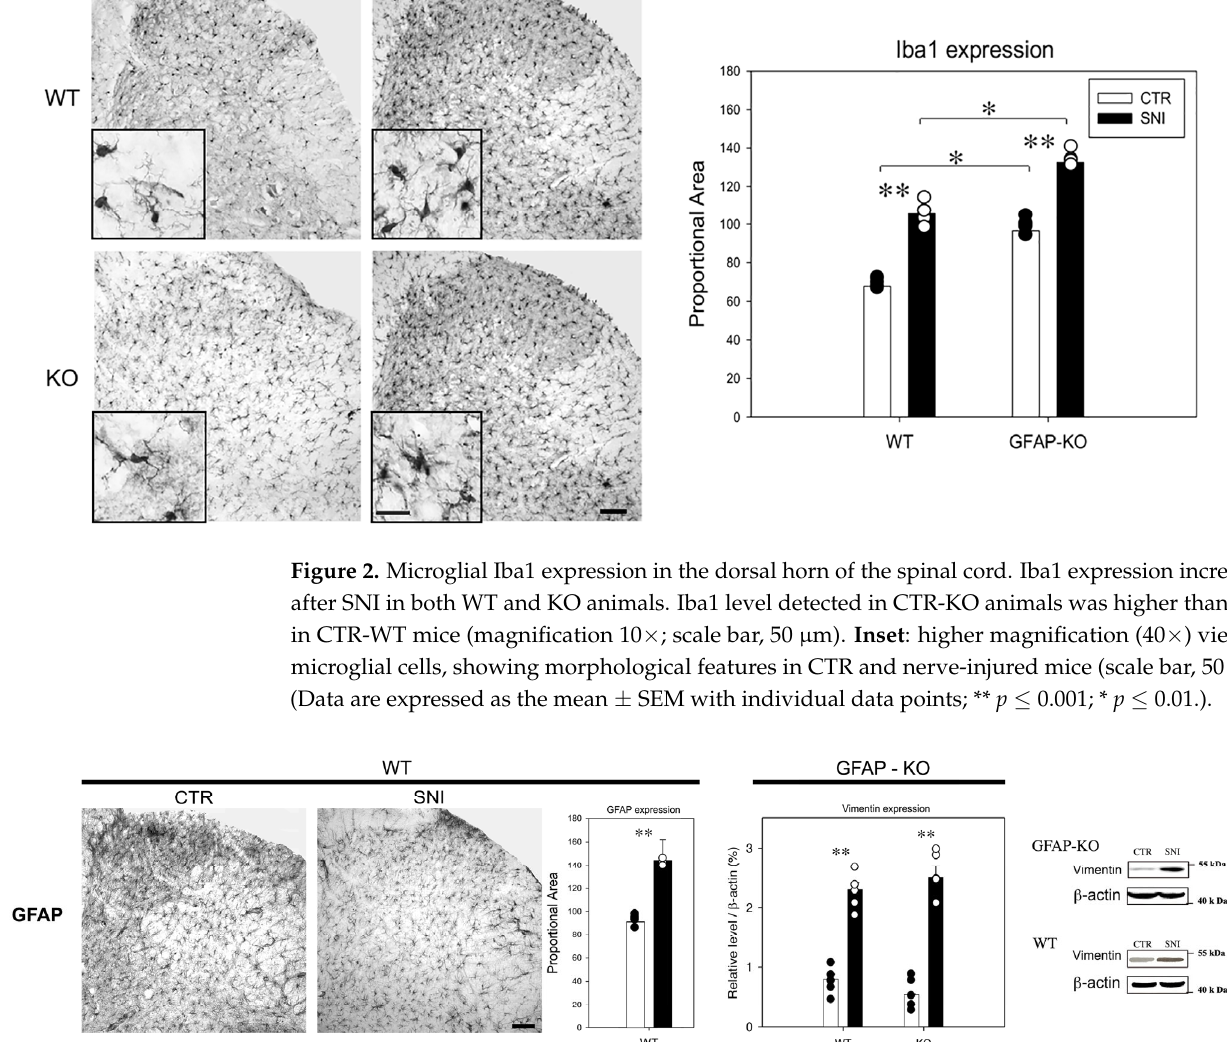
Figure 3. ( A ) GFAP expression in the dorsal horn of the spinal cord (magnification 10×; scale bar, 50  m). GFAP expression significantly increased after SNI in WT mice. ( B , C ) WB vimentin expression